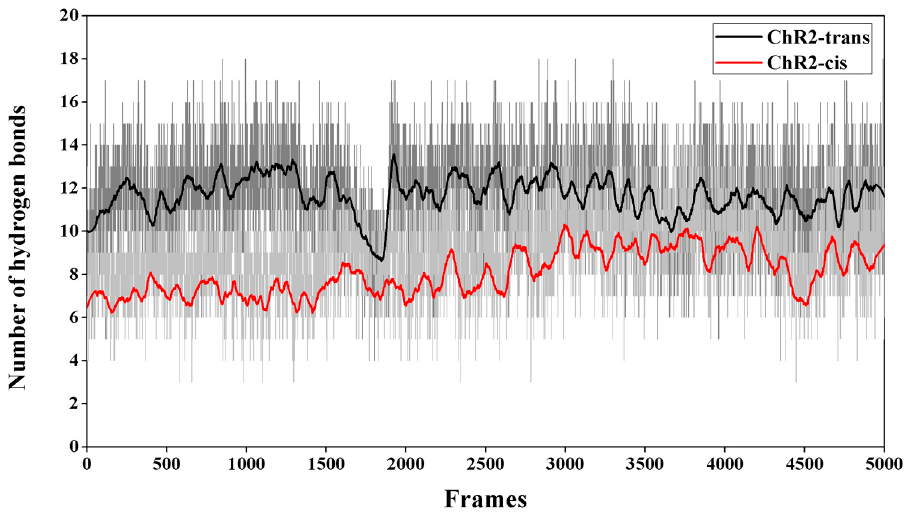
Figure 7. The number of hydrogen bonds between the residues and residues surrounding the channel (e.g., S63, E82, E83, E90, K93, E97, E101, Q117, R120, E123, T246, D253, N258, R268), as well as between residues and water molecules in the last 50 ns of equilibrium trajectory of ChR2-trans and ChR2-cis. It is apparent that ChR2-cis (red) has fewer hydrogen bonding interactions than ChR2-trans (black).